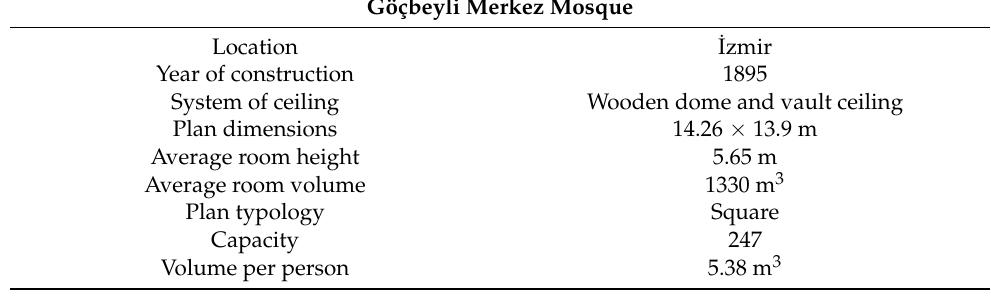
10 Figure 8. Main and women’s prayer hall of Çar ş ı Mosque (photos by the authors) . The main worship area and lodge for women have carpets as a floor-finishing mate- rial. The mimbar, sermon chair, women’s prayer hall, columns, and wall coverings up to 0.9 cm from the floor are made of wood. The mosque is positioned higher than the level